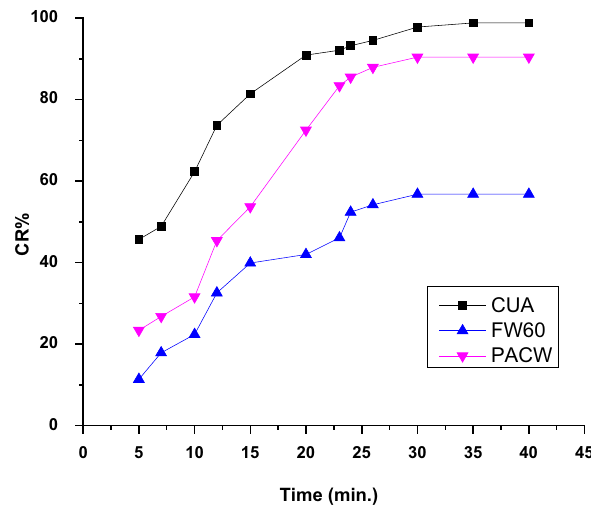
Fig. 9 Decolorization of SMJ as a function of